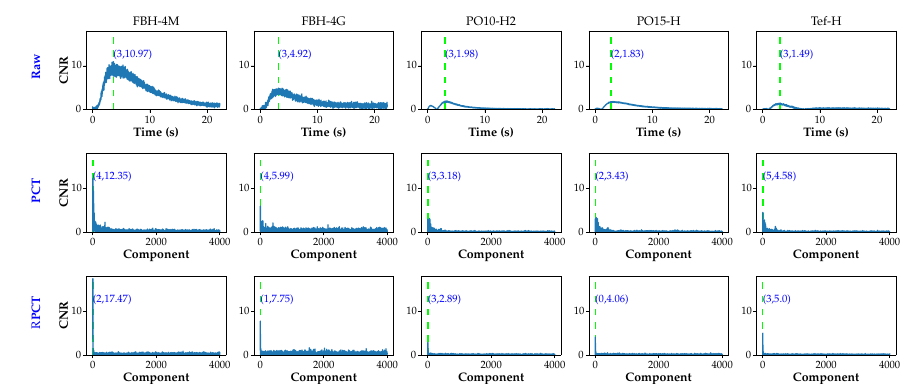
Figure 9. Comparative CNR curves for defects at the same depth (Z=1.43 mm) but different types (FBH, pull-outs and inserts): ( Row 1 ) raw data; ( Row 2 ) PCT; and ( Row 3 ) RPCT. Columns 1–5 represent FBH-4M, FBH-4G, PO10-F2, PO15-H, and Tef-H, respectively. To further analyze results, the CNRmax values are gathered by defect type in Figure 10 and by defect depth in Figure 11.